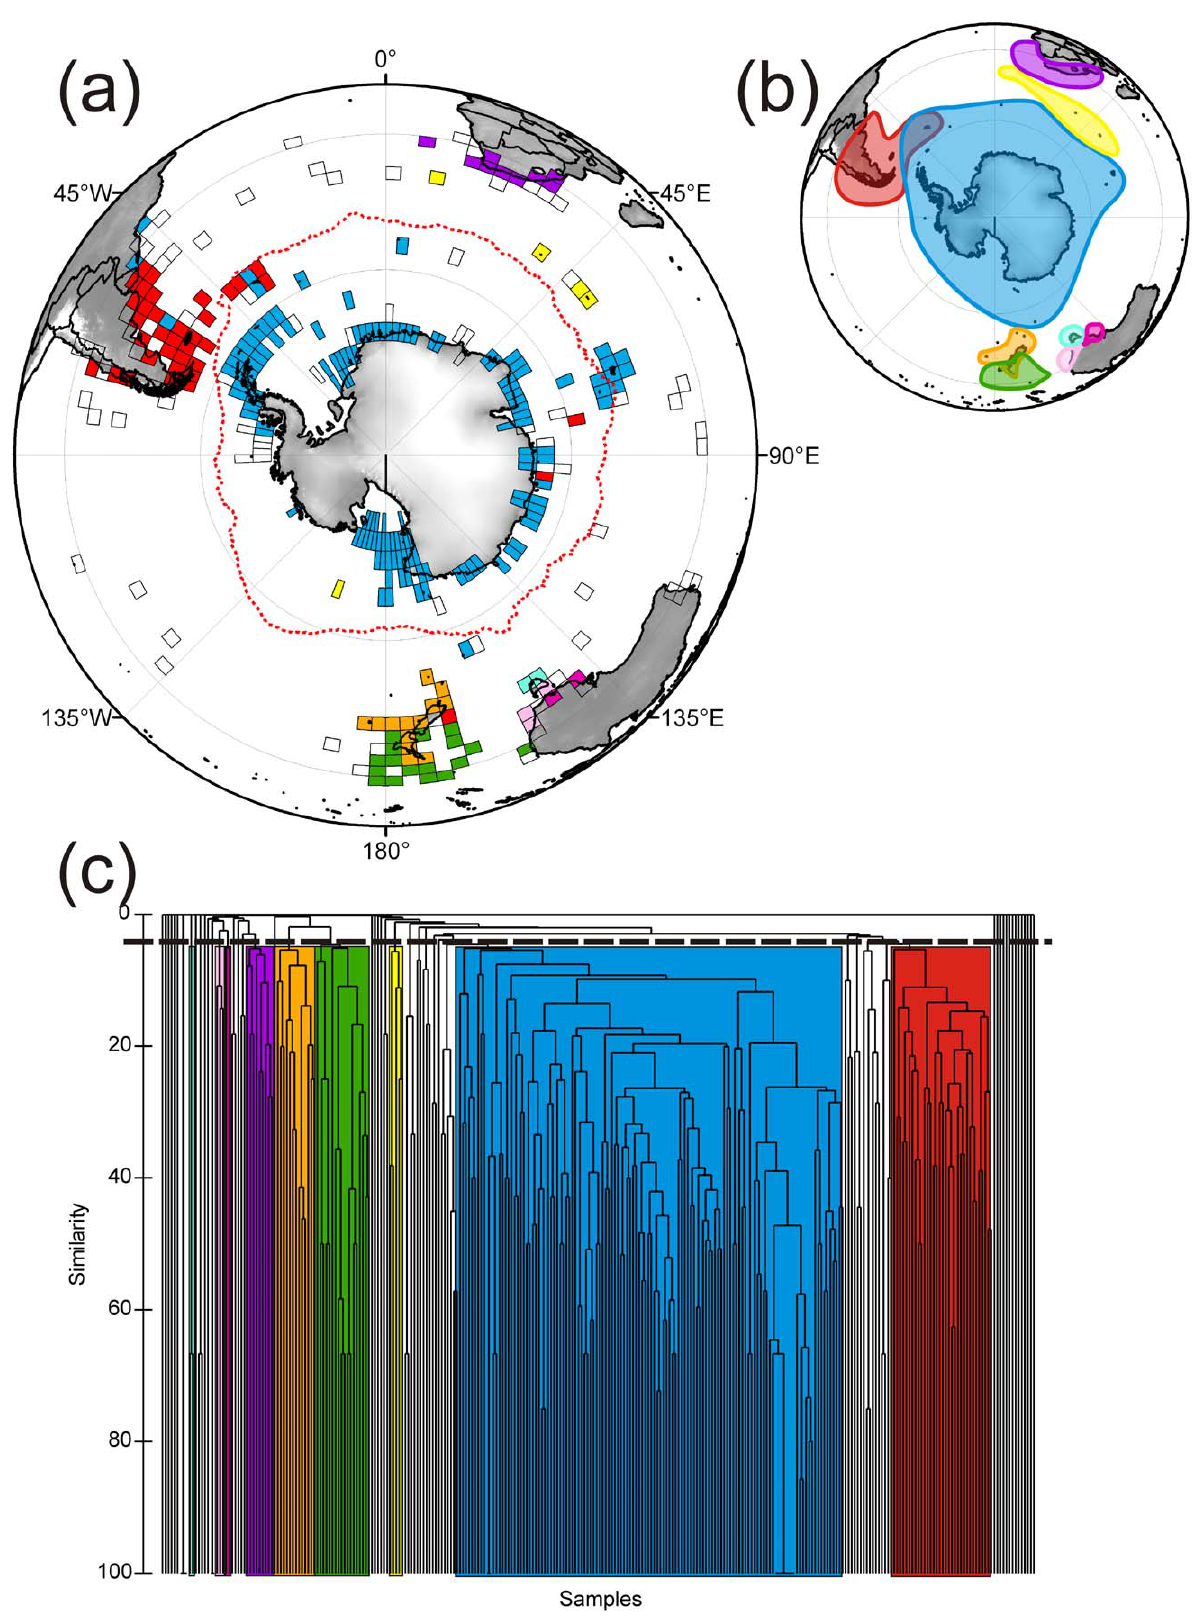
Figure 8. Large scale biogeographic relationships in demosponge species assemblage in 3 u by 3 u grid cells from the Southern Ocean and neighbouring regions. Each grid cell contains 3 or more species of demosponge. (a) Geographic representation of the relationships